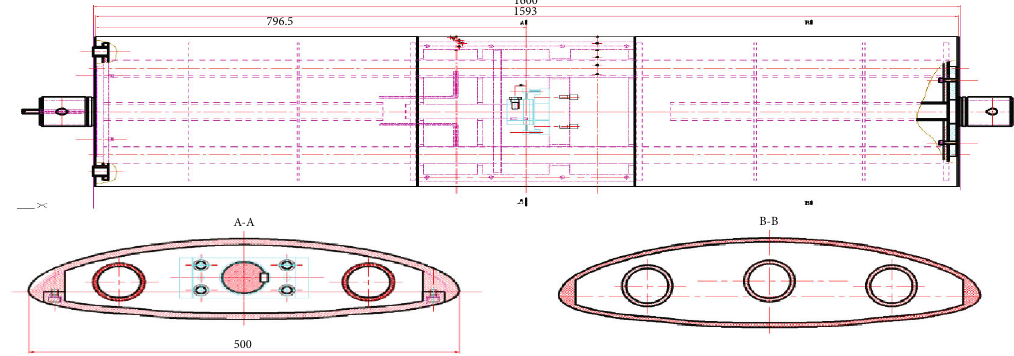
Figure 3: Model Structure.